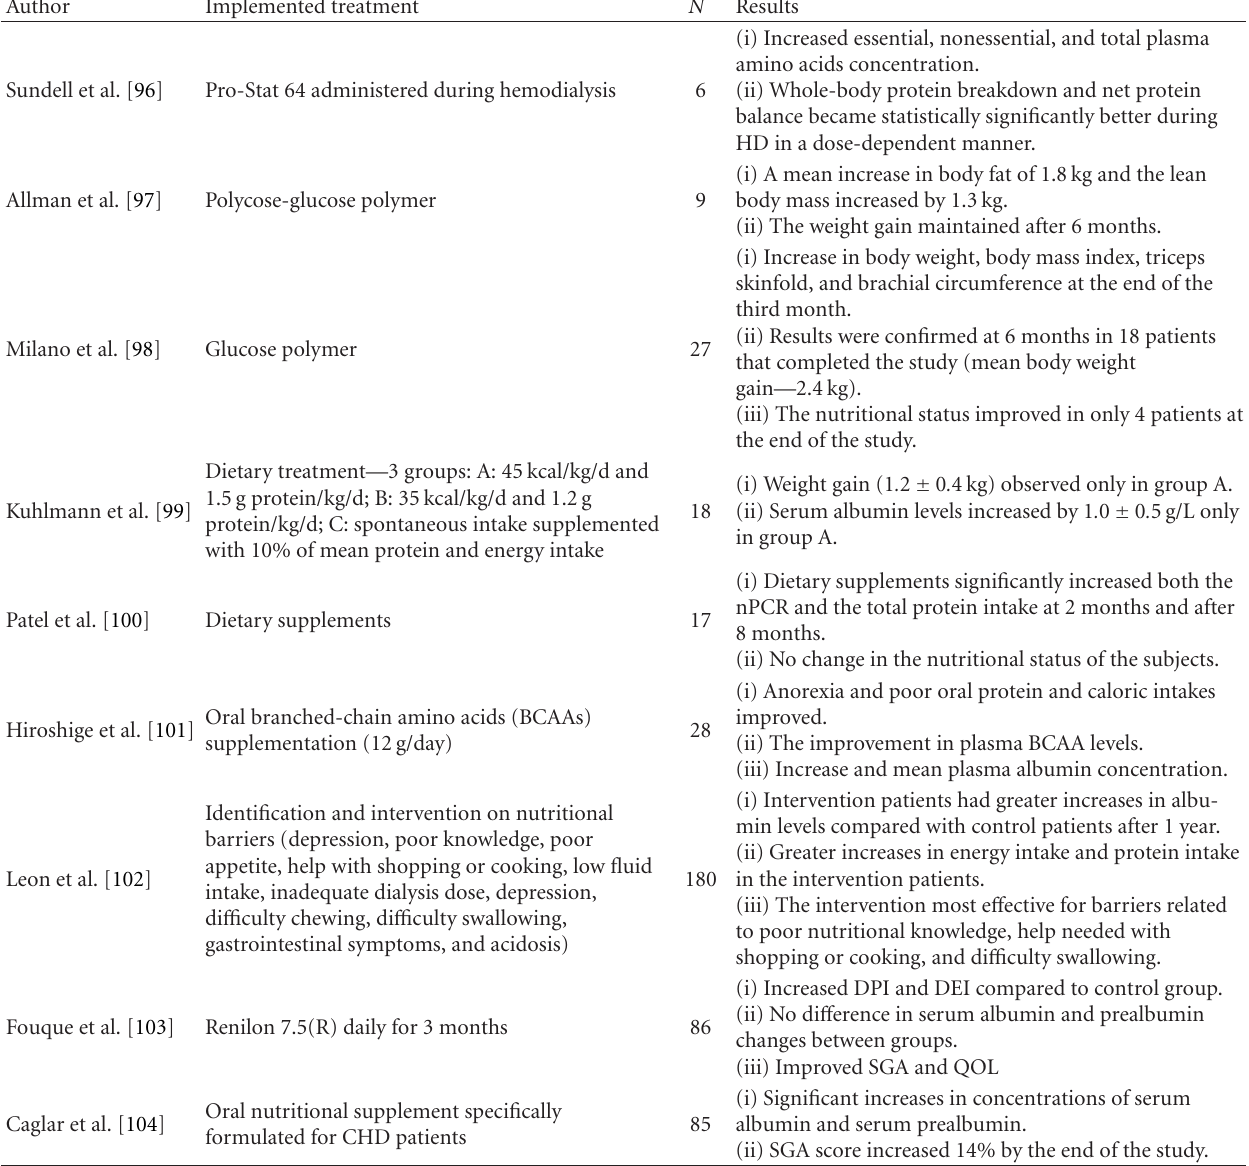
Table 1: Review of the most important randomized controlled trials concerning nutrition treatment in ESRD